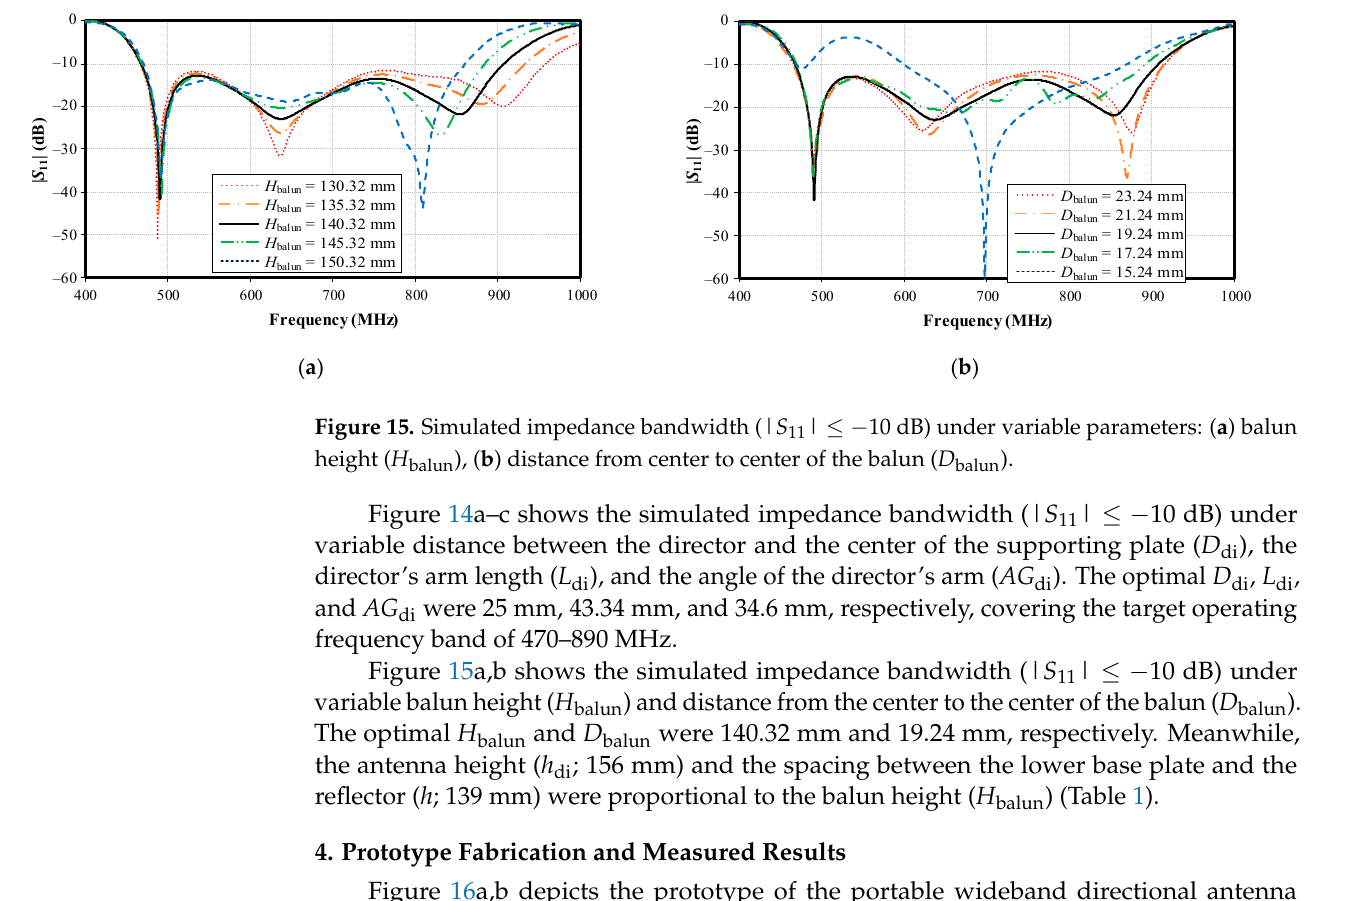
Figure 14. Simulated impedance bandwidth (| S 11 | ≤ − 10 dB) under variable parameters: ( a ) distance between the director and center of the supporting plate ( D di ), ( b ) director’s arm length ( L di ), and ( c ) angle of the director’s arm ( AG di ).